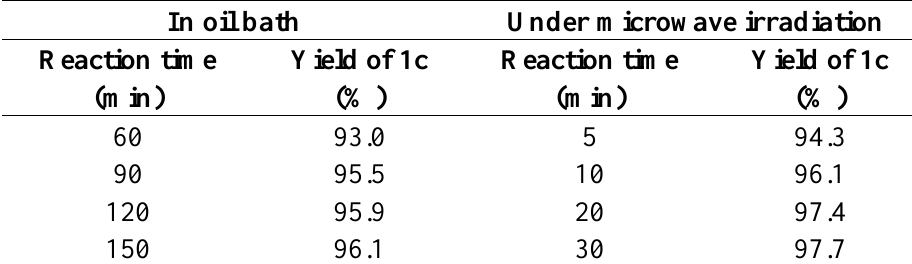
Table 4. Effect of reaction time on the yield of 1c